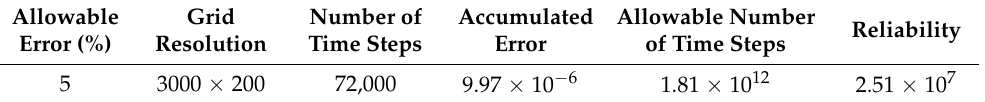
Table 4. Error estimates.